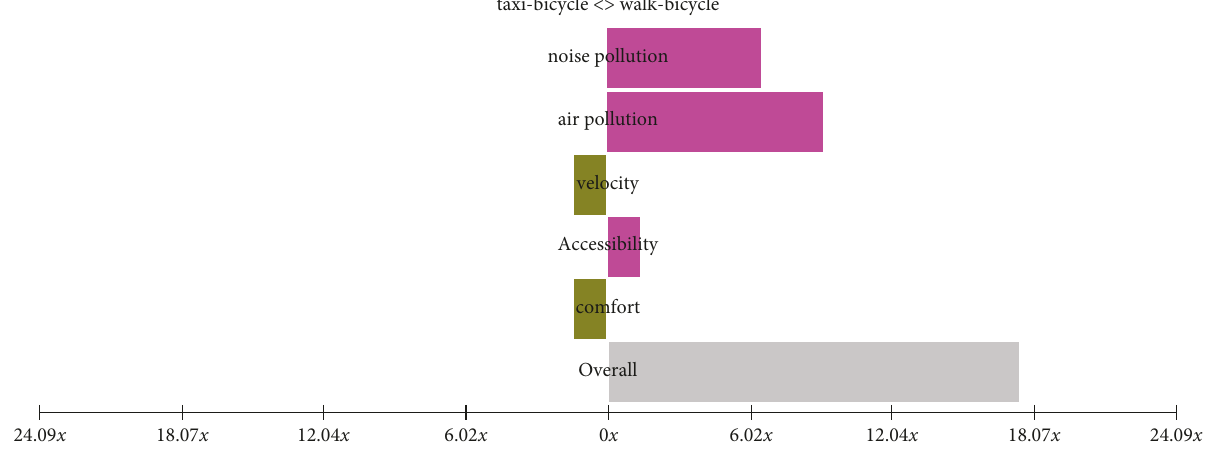
Figure 6: Comparison of two mixed modes with different